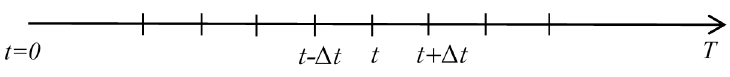
Figure 2. Discretization of the time horizon.